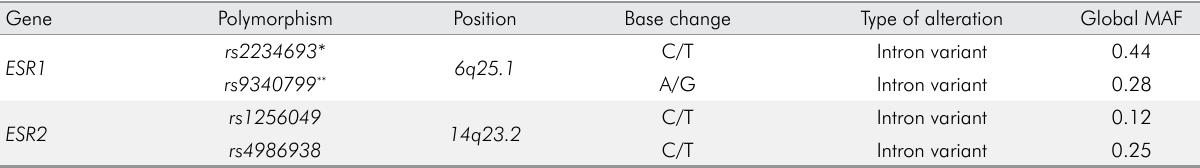
Table 1. Genes and genetic polymorphisms investigated in this